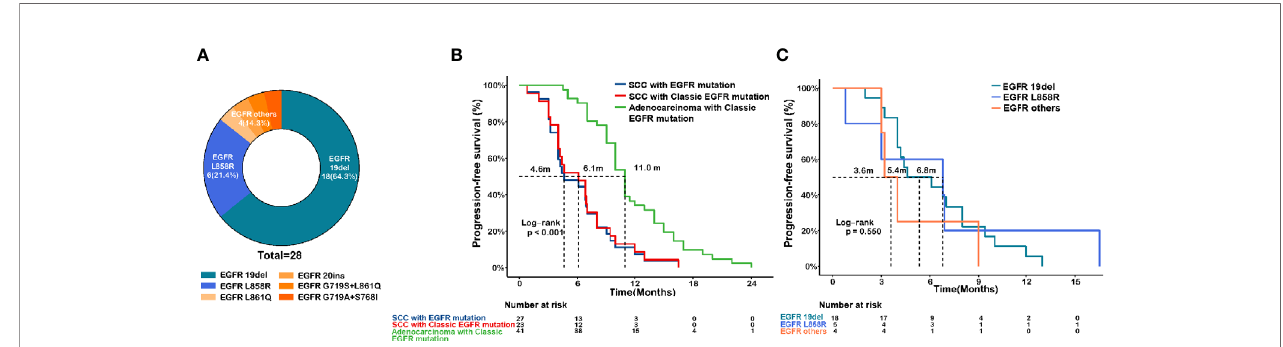
FIGURE 1 | EGFR mutational subtypes and survival analysis in EGFR -mutated lung squamous cell carcinoma (SCC) and adenocarcinoma. (A) Mutation subtypes of EGFR -mutant lung SCC. (B) Kaplan-Meier curves of progression-free survival (PFS) comparing the SCC patients harboring EGFR mutation (n=27, blue) or classic EGFR mutation (19del or L858R, n=23, red), and in adenocarcinoma patients harboring classic EGFR mutation (19del or L858R, n=41, green). (C) Kaplan-Meier curves of PFS in SCC patients harboring 19del (n=18, green), L858R (n=5, blue), or other uncommon mutations